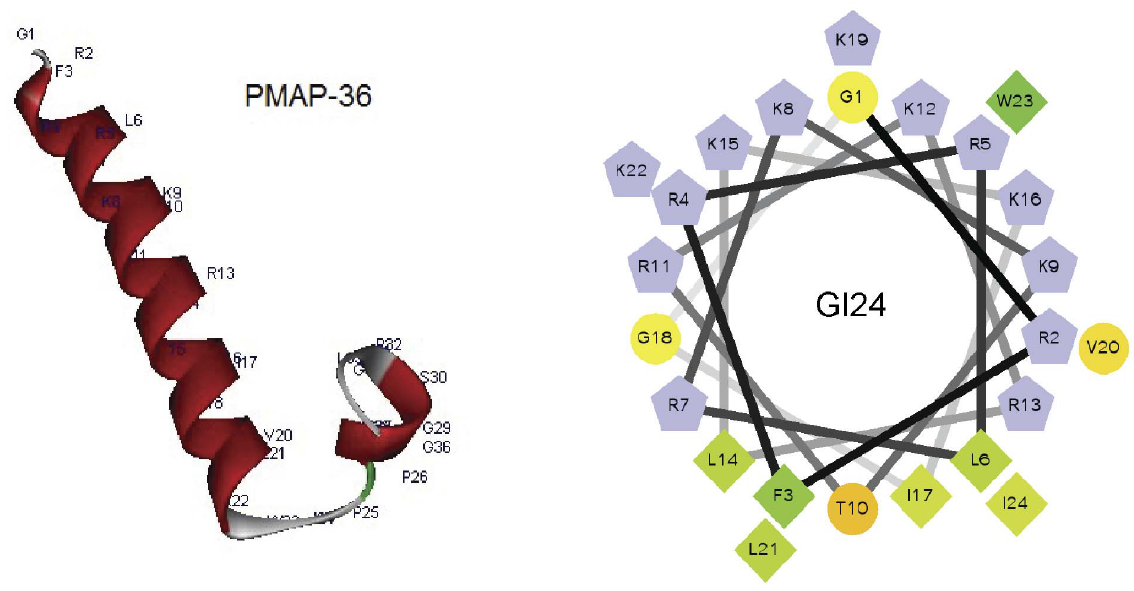
Figure 1. Three-dimensional structure projections of PMAP-36 (left) and helical wheel projections of GI24 (right). In the picture of helical wheel projections of GI24, by default the output presents the hydrophilic residues as circles, hydrophobic residues as diamonds, and potentially positively charged as pentagons. Hydrophobicity is color coded as well: the most hydrophobic residue is green, and the amount of green is decreasing proportionally to the hydrophobicity, with zero hydrophobicity coded as yellow. Hydrophilic residues are coded red with pure red being the most hydrophilic (uncharged) residue, and the amount of red decreasing proportionally to the hydrophilicity. The potentially charged residues are light blue.